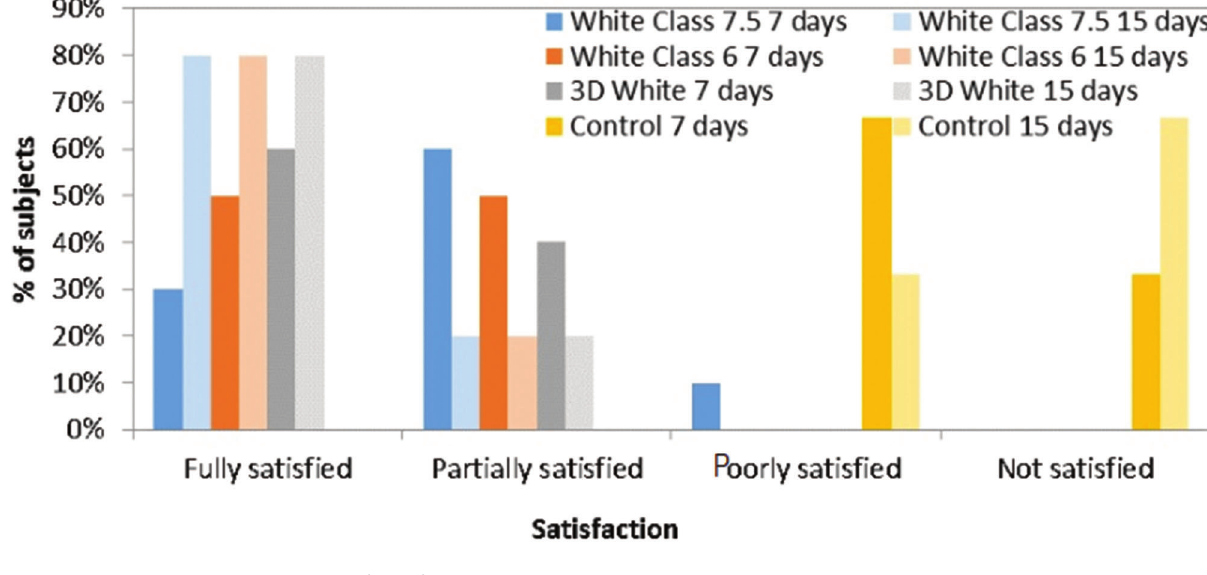
Figure 4 - Subjects ’ overall perception of satisfaction.